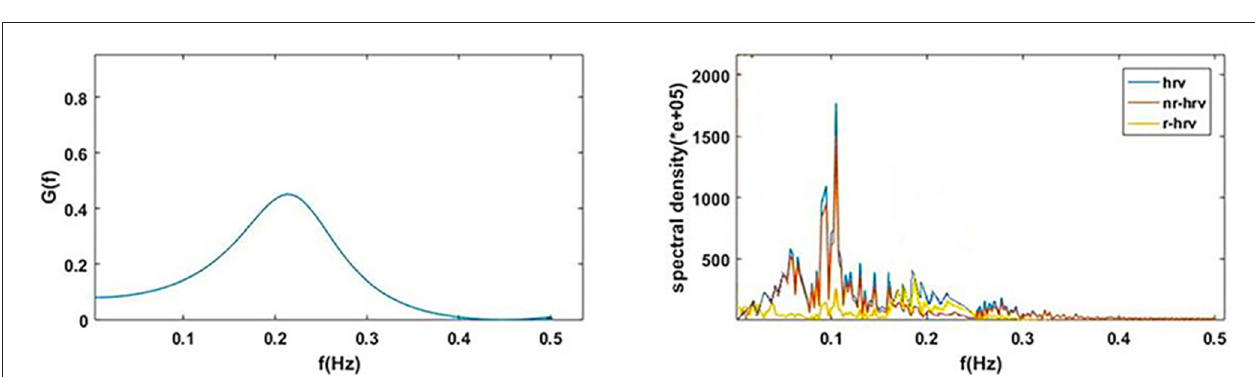
Frontiers in Physiology |